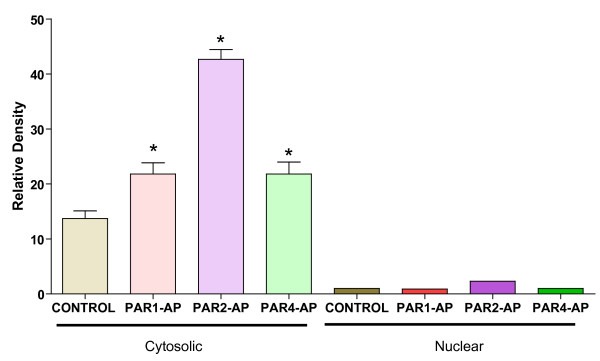
Average densitometric values of PAR-APs induce up-regulation of iPLA2 in the mouse urinary bladder (Figure 6).